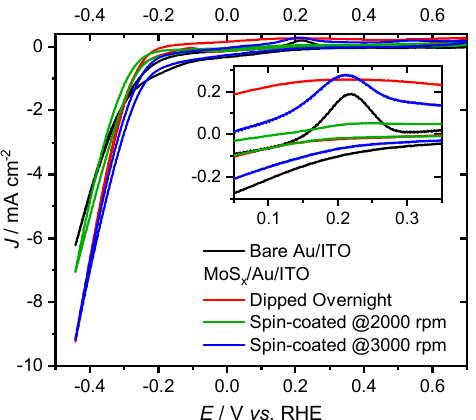
/ ITOelectrodespreparedusing[Mo Figure 7. CVs recorded for bare and MoS x -coated Au/ITO electrodes prepared using Figure 7. CVcurvesrecordedforbareandMoS x -coatedAu 3 S 7 (S 2 CNMe 2 ) 3 ]I in THF by spin coating and overnight immersion methods. Electrolyte: 0.5 M H 2 SO 4 . The inset of the figure shows the zoom-in features of Au oxidation near 0.2 V vs. RHE.